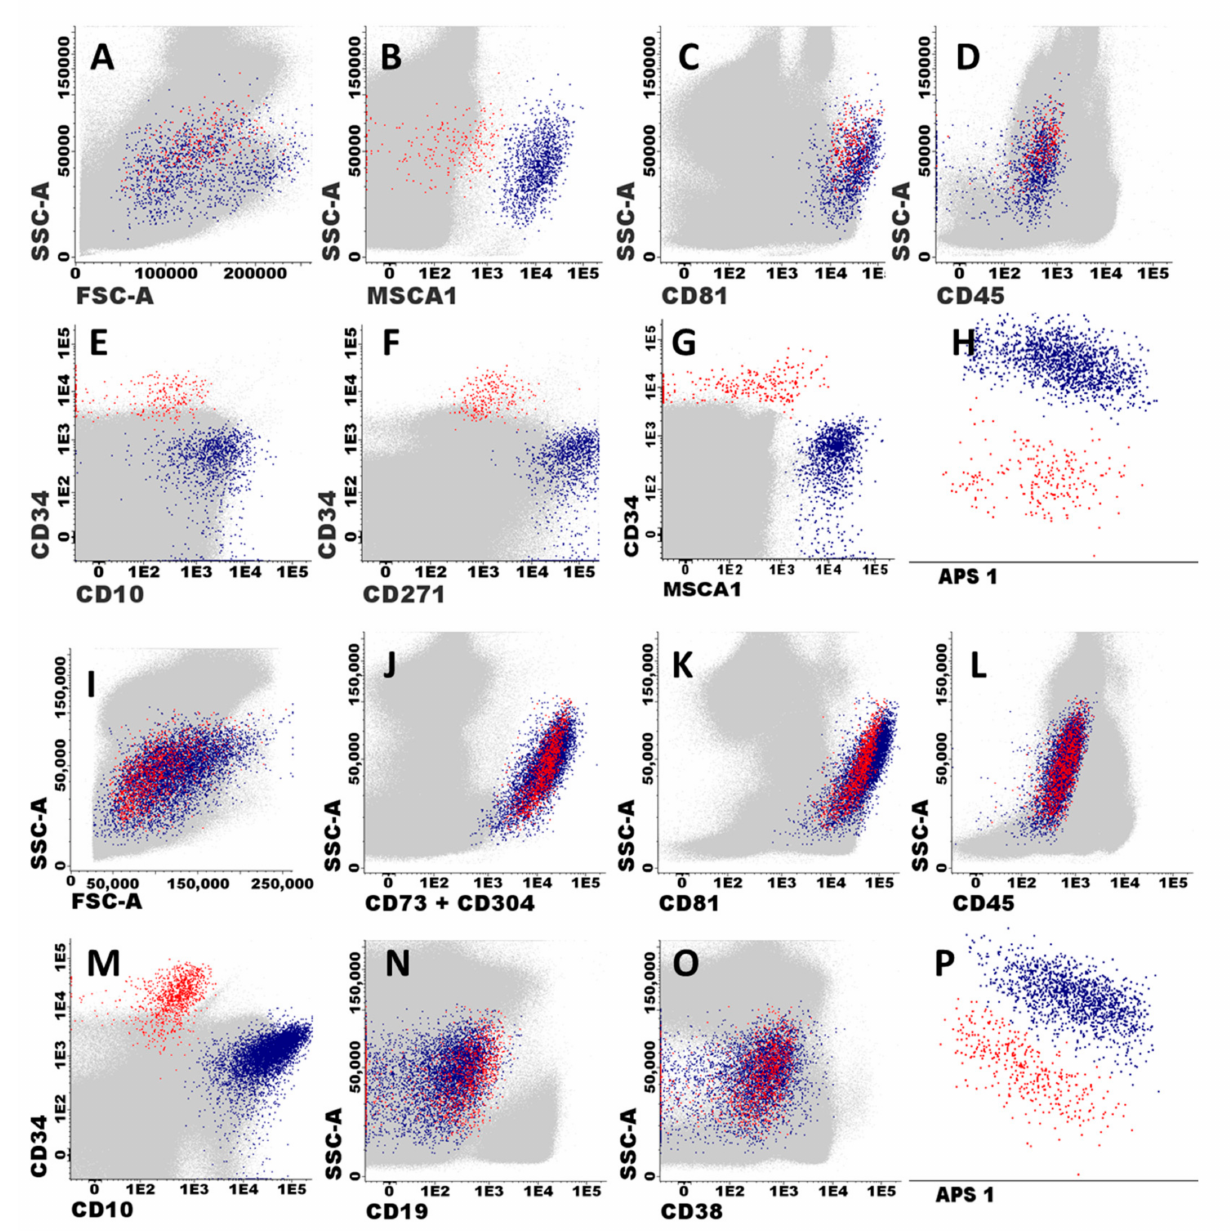
Figure 1. Immunophenotypic identification and characterization of BM stromal cells. Panels ( A – H ) il- lustrate the immunophenotypic pattern of expression of classical stromal cell-associated markers on mesenchymal stem cells (MSC) and endothelial cells (EC). MSC (blue dots) and EC (red dots) shown in all panels were identified as CD81 hi , (CD73 hi ), and CD45 − cells ( B – D ), which typically co-expressed MSCA1 + , CD271 + , and CD10 hi in the absence of CD34 (MSC), or they were CD34 + in the absence of MSCA1, CD271, and CD10 expression (EC), respectively. Other BM cells are depicted as grey events. Panels ( I – P ) illustrate how BM stromal cells (EC and MSC) were specifically identified and classified after staining with the EuroFlow BCP-ALL MRD antibody panel (Tube